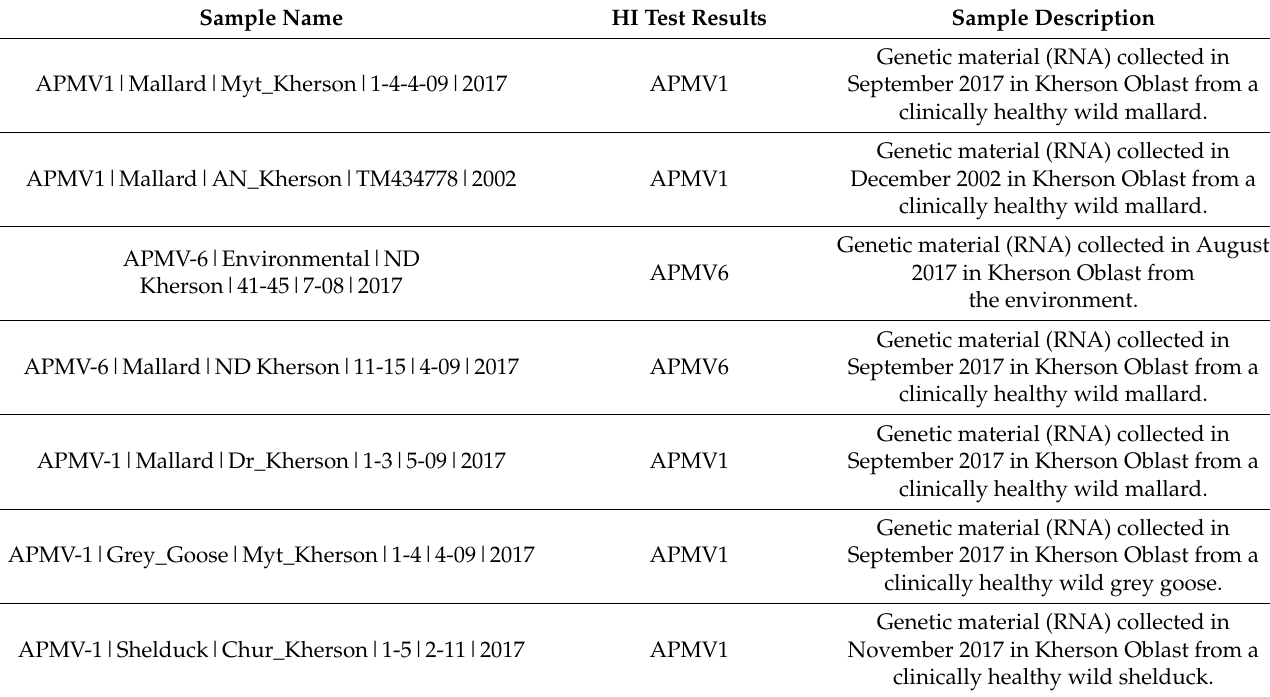
Table 1. APMV viruses isolated from Ukraine during the 2016–2017 field season. Both APMV-1 and APMV-6 were predominately isolated from the southern Oblasts of Ukraine. HI = hemagglutinin